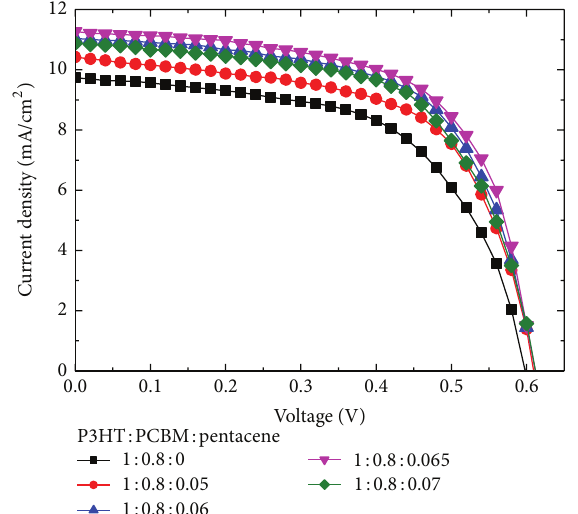
Figure 9: The current density-voltage characteristics of the inverted PSCs (solar cells A, B, C, D, and E).